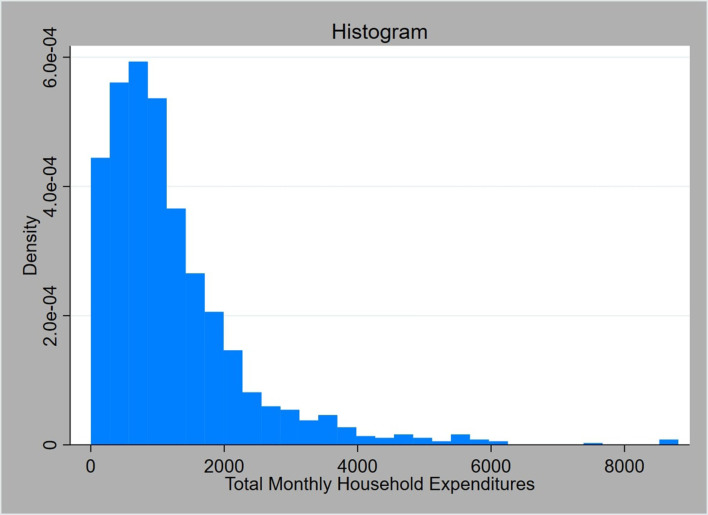
Histogram: household expenditures.